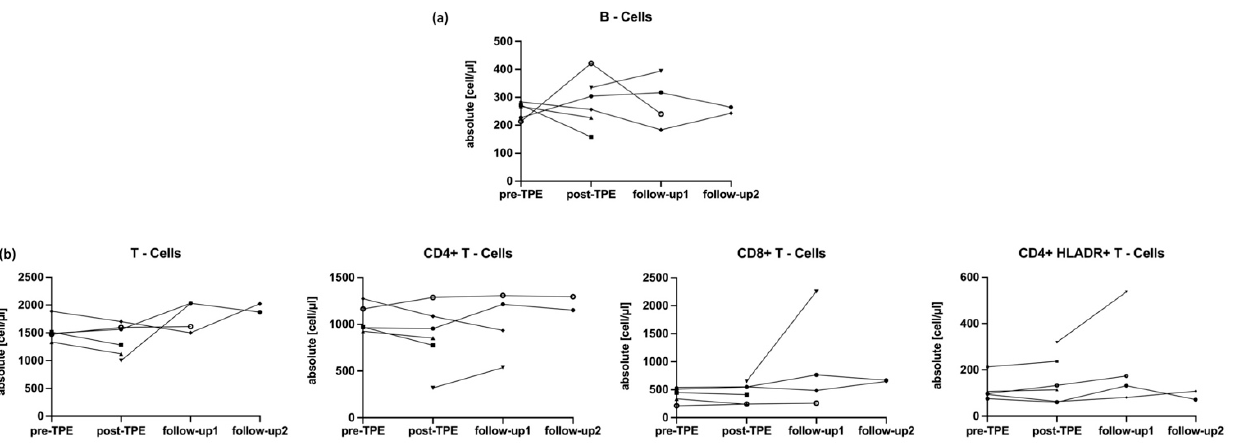
Figure 3. Quantitative changes in major lymphocyte subpopulations associated with TPE. TPE did not impact on B cells ( a ) and had no substantial effects on any of the assessed T lymphocytes ( b ) including T helper cells (CD4+), cytotoxic T cells (CD8+) and proinflammatory T helper cells expressing HLADR. Follow-up1 and follow-up2 were conducted 5 weeks and 130 days after the last TPE session, respectively. Lymphocyte data were available in five individuals at pre-TPE, in six at post-TPE and in four and two at the respective follow-ups. Data from individuals treated with immunosuppressive drugs (anti-CD20 monoclonal antibodies n = 2; azathioprine n = 1) and/or with intravenous immunoglobulins (IVIG; n = 5) after TPE were excluded from the respective follow-ups. One patient was lost to follow-up after TPE. Symbols and connecting lines show the raw data of each patient included at the respective time of sampling. Pre-TPE = prior to therapeutic plasma exchange; post-TPE = immediately after therapeutic plasma exchange.